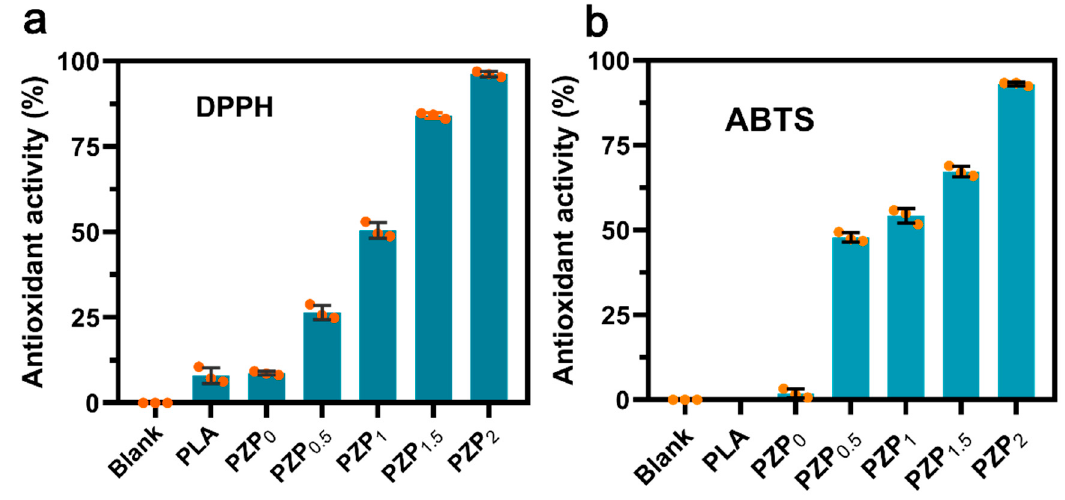
Figure 5. ( a ) DPPH scavenging activity and ( b ) ABTS scavenging of PLA based composite Figure 5. (a)DPPH scavenging activity and (b) ABTS scavenging of PLA based composite films.